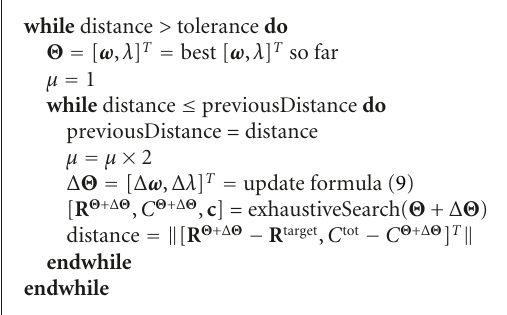
Algorithm 1: Lagrange multiplier search